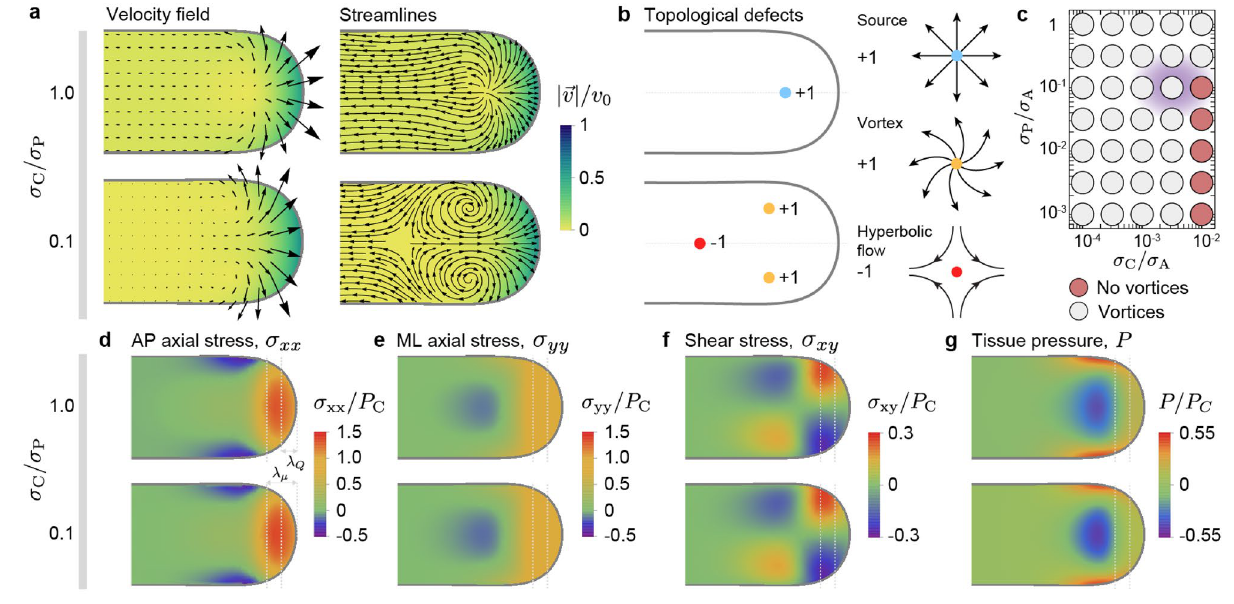
Figure 4. Morphogenetic flows and stress field during unidirectional elongation of the body axis. ( a , b ), Velocity field and streamlines of morphogenetic flows for different values of σ C / P C , showing two structurally different flow fields ( a ). For large capillary stresses σ C , the flow emerges from a single topological defect ( a ; source) of charge + 1 ( b ). For lower capillary stresses, the tissue flow dramatically changes its structure and is characterized by three topological defects, namely 2 counter-rotating vortices (each with charge + 1 ) and a stagnation point associated with hyperbolic flow (with charge − 1 ). The remaining parameter values for each case are those indicated in Fig. 2a for unidirectional elongation (UE) in the absence and presence of vortices, labelled nv (no vortices) and v (vortices), respectively. ( c ), Diagram indicating the structure (presence or absence of vortices) of tissue flows. The tissue morphogenetic flows sharply transit from the two flow structures shown in ( a ) as the parameters are changed. The diffuse violet color indicates the estimated parameter region for wild type zebrafish body axis elongation. ( d – g ), Spatial distribution of all components of the stress tensor, namely the AP axial stress σ xx ( d ), the mediolateral stress σ yy ( e ) and the shear stress σ xy ( f ), as well as the tissue pressure P ( g ), for the two examples of tissue flows shown in panel ( a ). Despite the dramatically different structures of the flow field, the stresses are very similar. Both the location of the fluid-to-solid transition and the size of the region where cells enter ventral tissues are indicated by gray dashed lines at distances (cid:31) µ and (cid:31) Q , respectively, from the posterior body